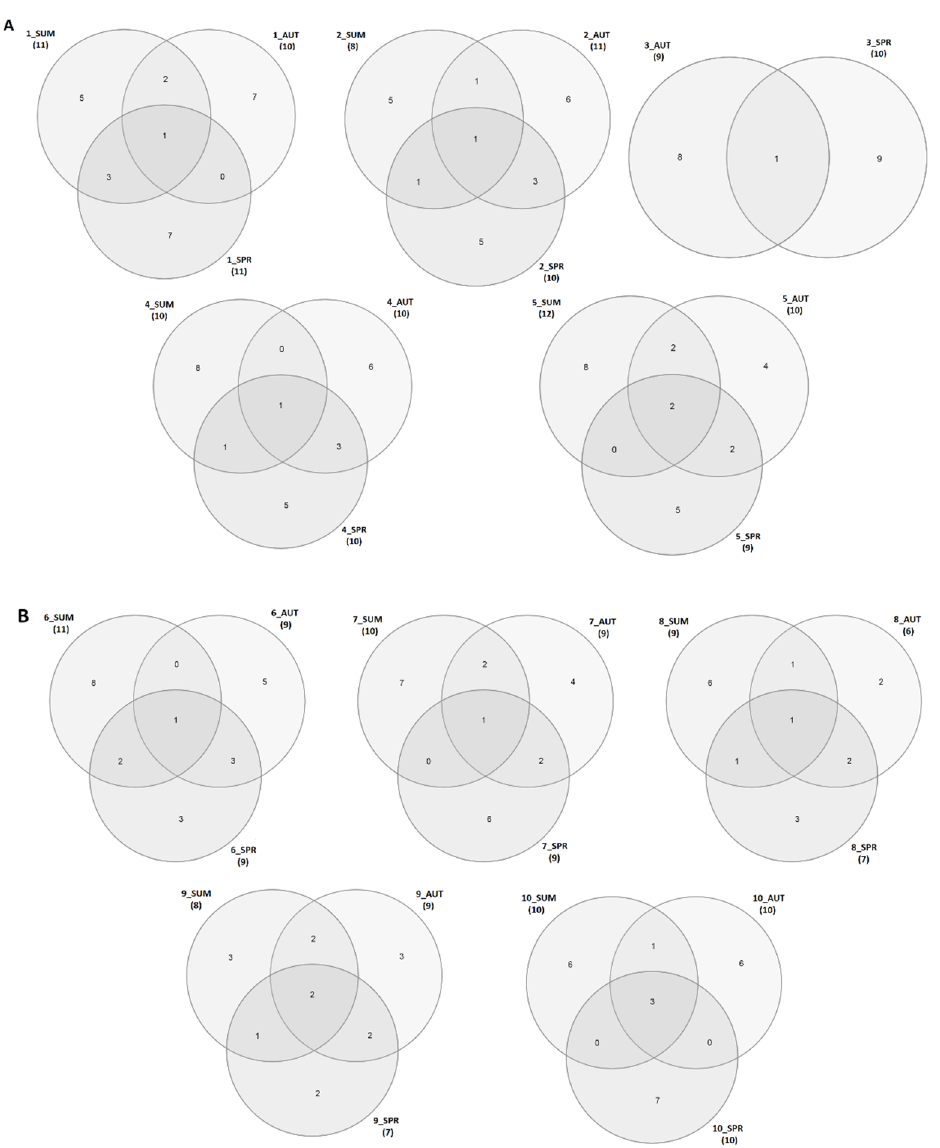
Figure 6. Venn diagrams illustrate the pathogens from WHO multi-resistant pathogens list in the samples collected from different technological steps. ( A ) Samples 1–5; ( B ) Samples 6–10; summer— SUM; autumn—AUT; spring—SPR.